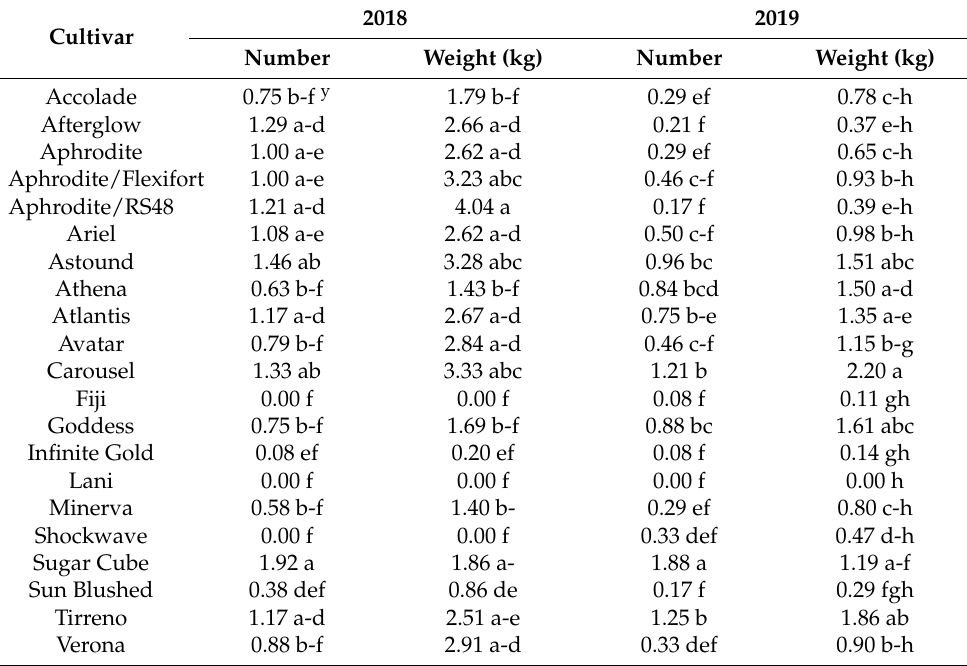
Table 3. Mean marketable fruit number z and weight per plant of 20 muskmelon cultivars and two grafted entries evaluated in western Pennsylvania in 2018 and 2019.